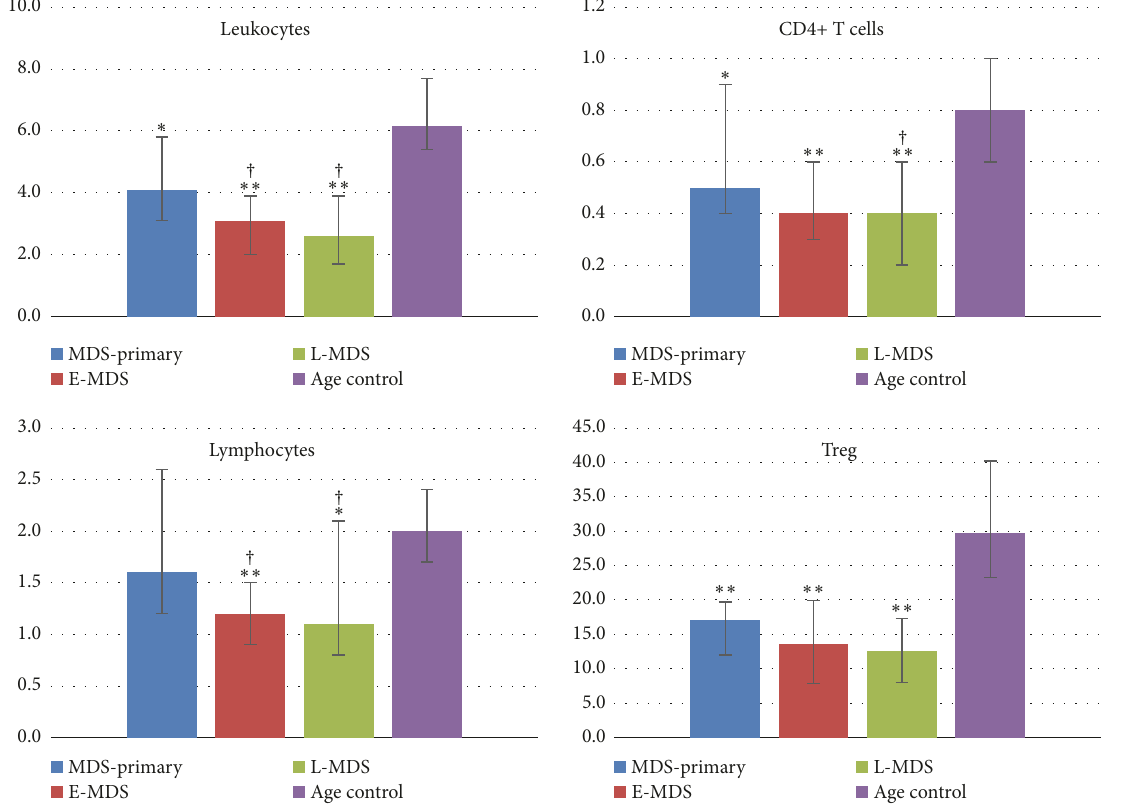
Figure 2: The absolute number of cell populations in the peripheral blood of MDS patients and age-matched healthy donors (10 9 cells/L, and Treg: 10 6 cells/L). Note: ∗ p < 0.05 rel. to age control; ∗∗ p < 0.001 rel. to age control; † p < 0.05 rel. to MDS-primary. MDS-primary: primary